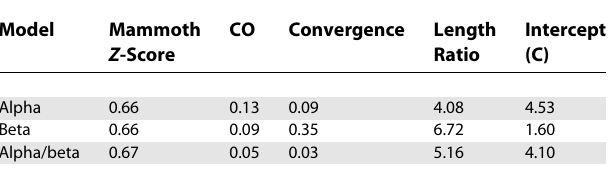
Table 3. MAMMOTH Confidence Metric (MCM) Logistic